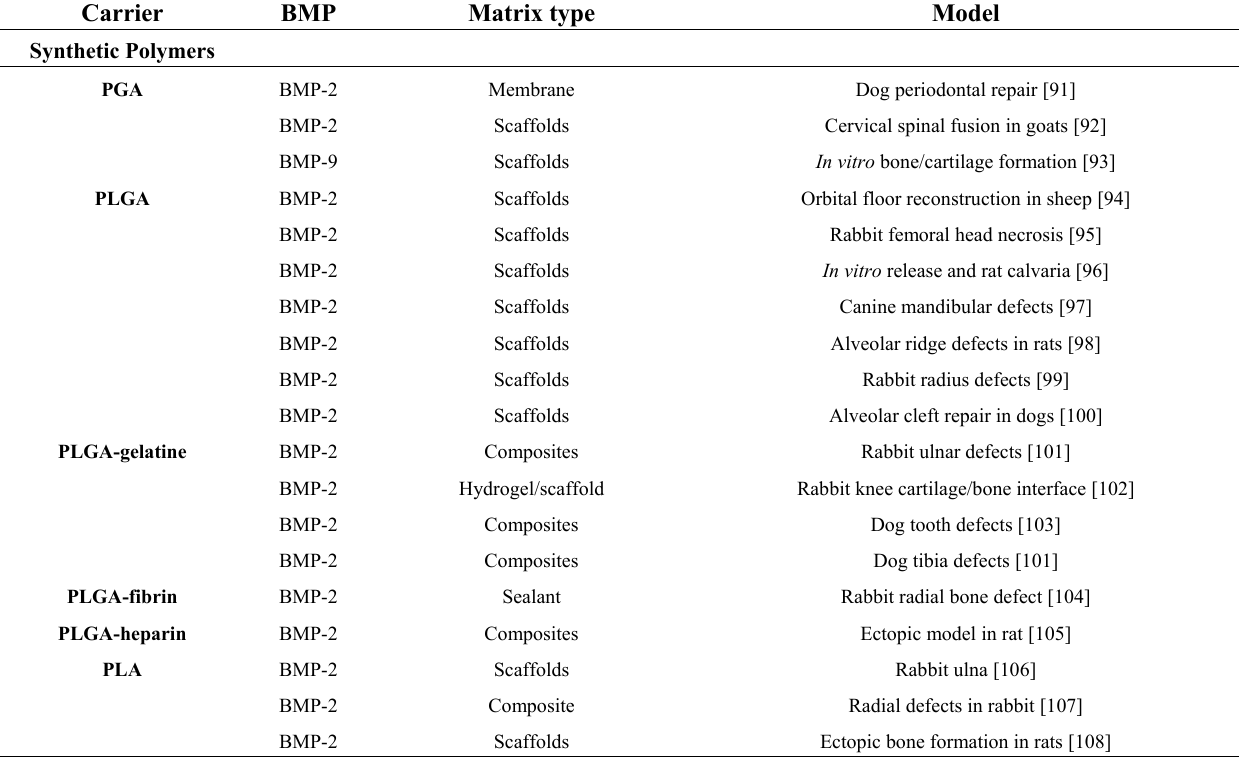
Table 2. Biomaterial carriers investigated for BMP delivery in bone tissue